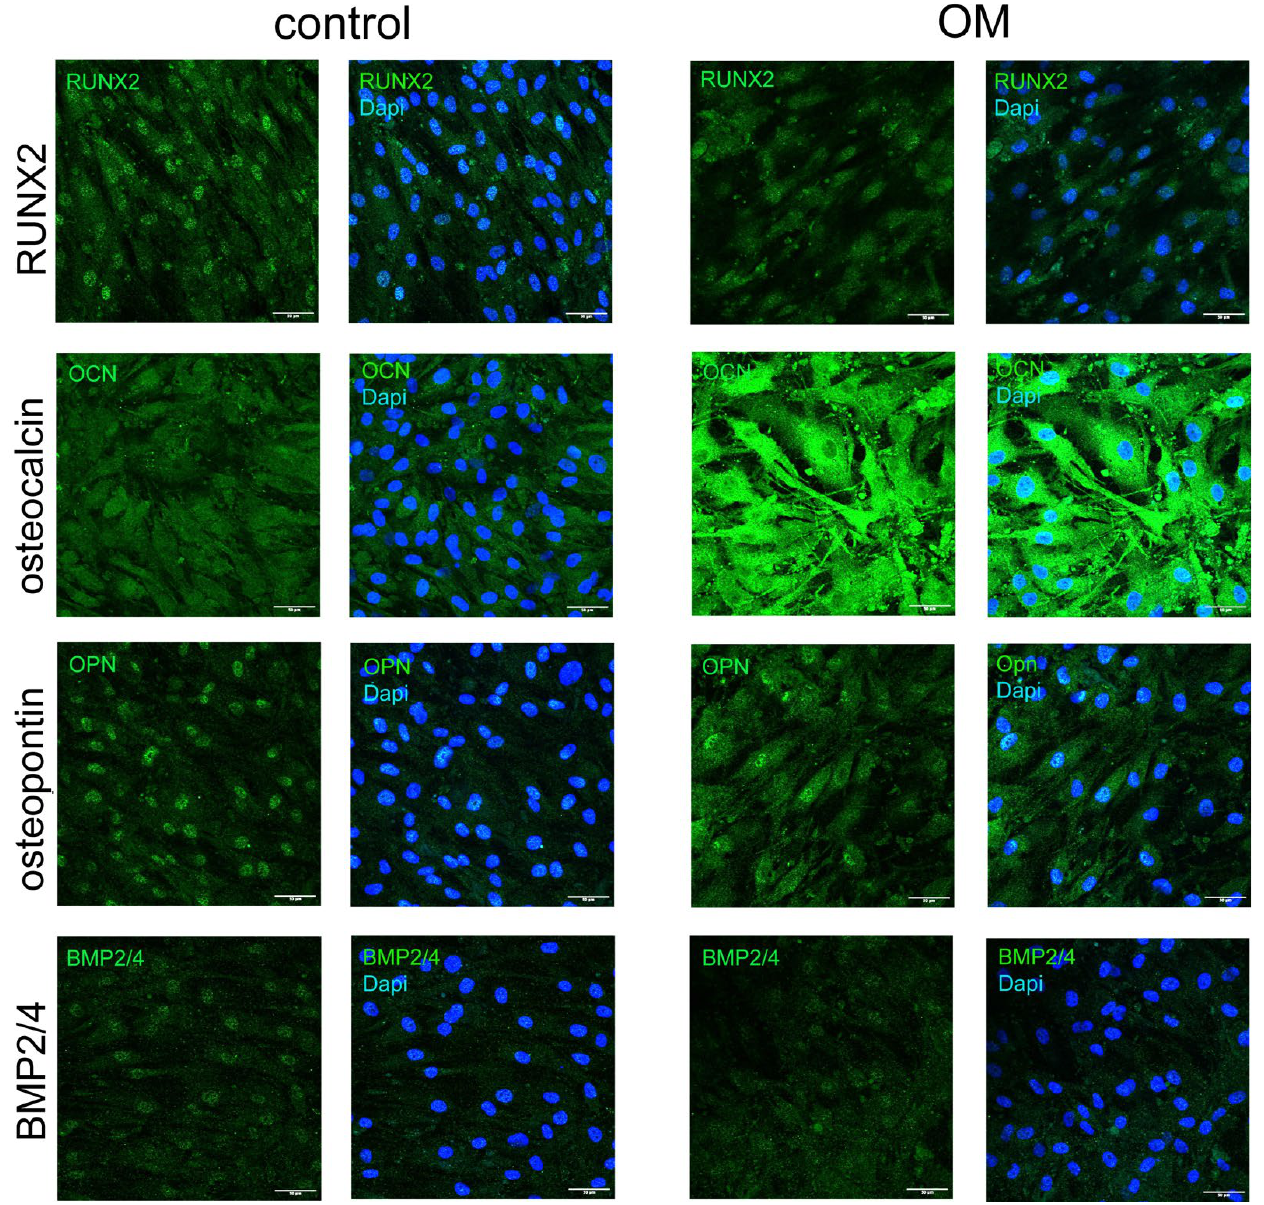
Figure 6. Immunocytochemical staining of OB cells shows that these cells express osteomarkers both in control and differentiative conditions. Osteo medium (OM) was added to 96 h. Osteocalcin was upregulated in differentiative